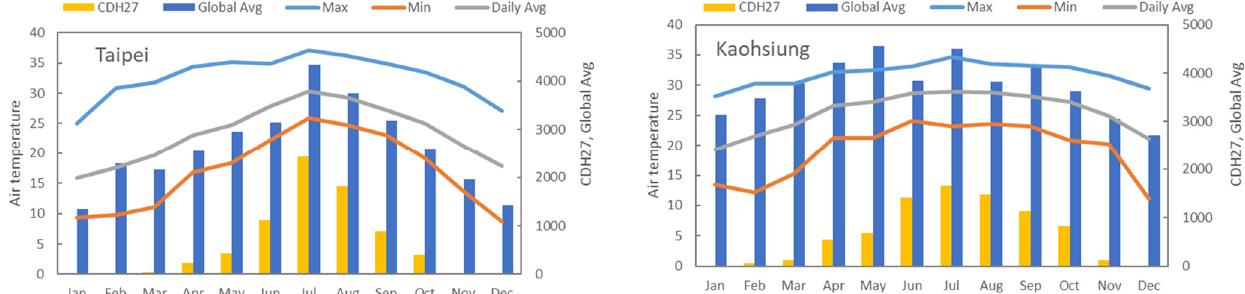
Figure 3. Climatic conditions of selected cities.